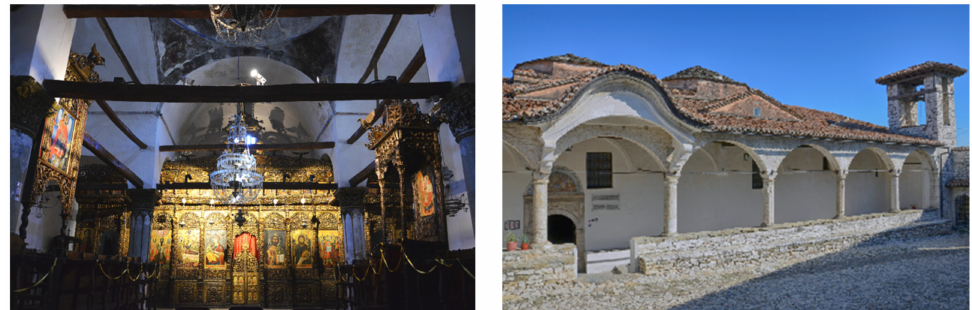
Figure 3. Internal ( left ) and external ( right ) views of the St Mary Assumption’s church of